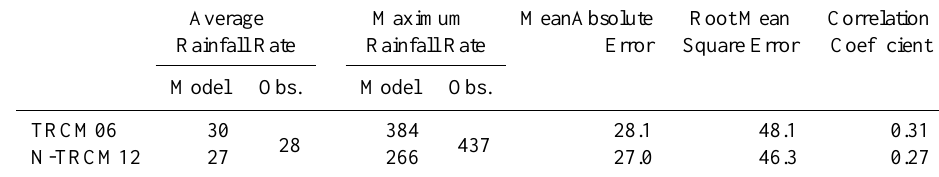
Table 5. Validation results for the statistical parameters of independent northward-moving typhoons that hit Taiwan in 2007–2011.